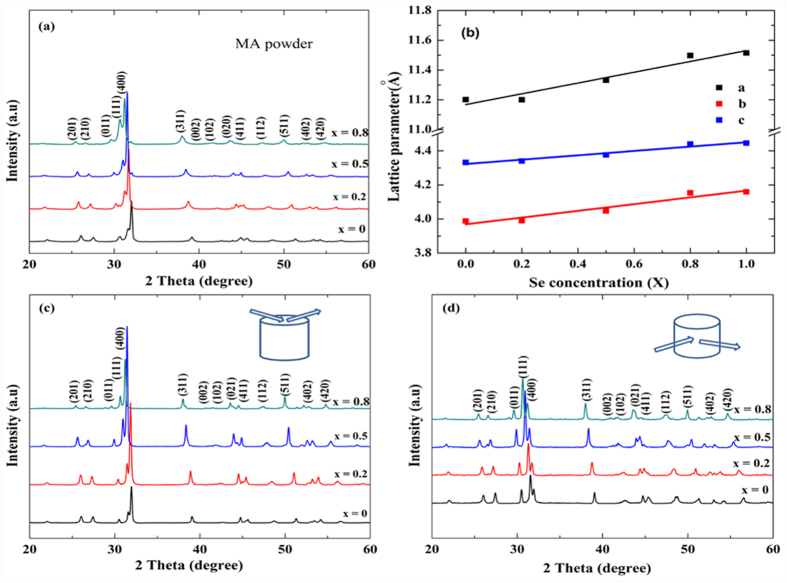
(a) XRD patterns of SnS1−xSex (x = 0, 0.2, 0.5, 0.8) MA–powders. (b) Lattice parameters of SnS1−xSex solid solutions varying with the increase in Se content (x). (c,d) XRD patterns of SnS1−xSex bulk specimens cut along two different directions.